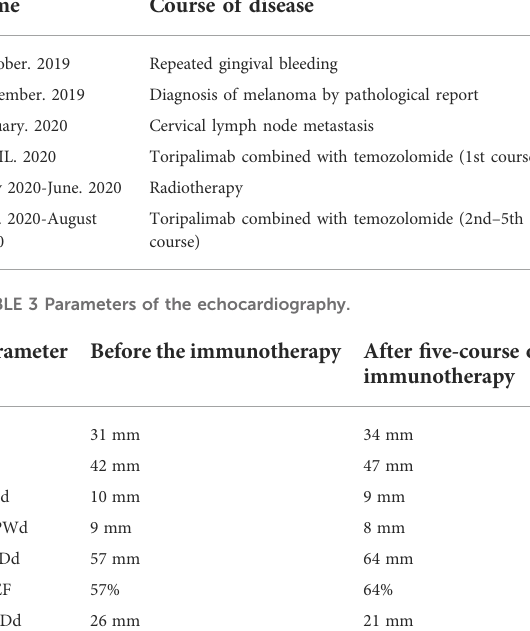
TABLE 2 Timeline of the medical process.